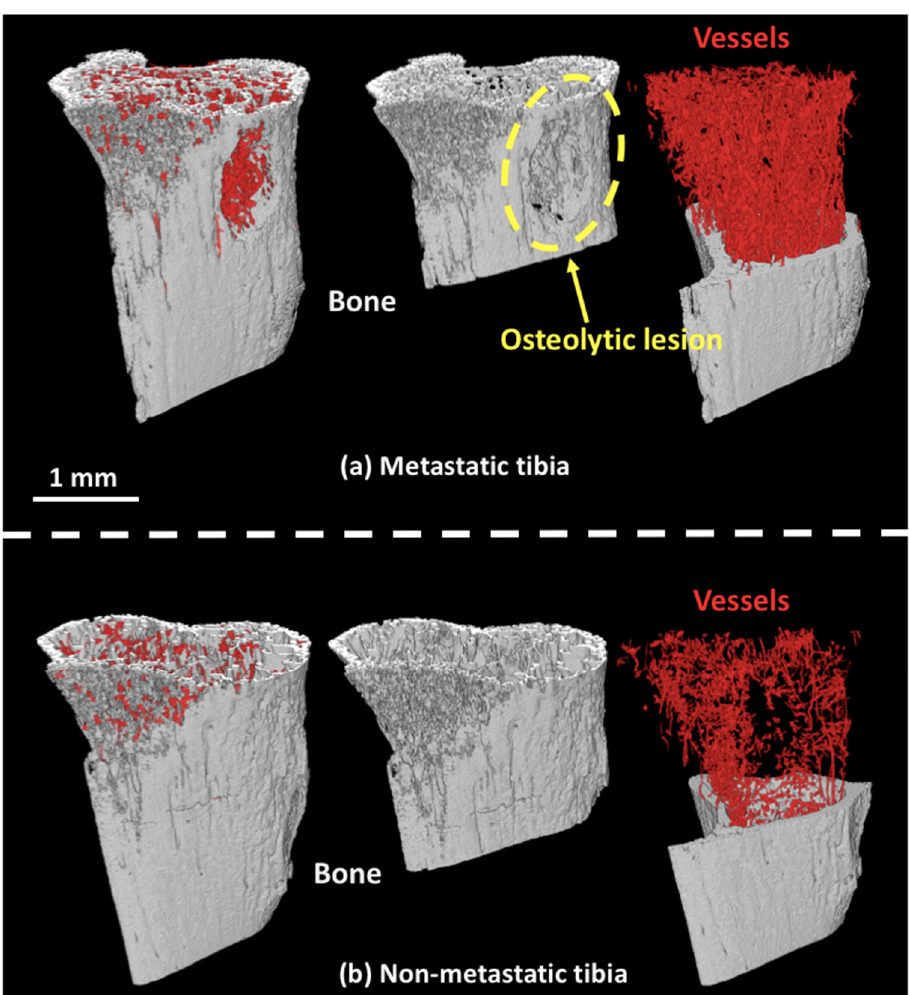
Figure 2. ( a ) 3D rendering of the segmented bone (gray) and blood vessels (red). ( b ) Same as in ( a ) for non ‐ metastatic bones.